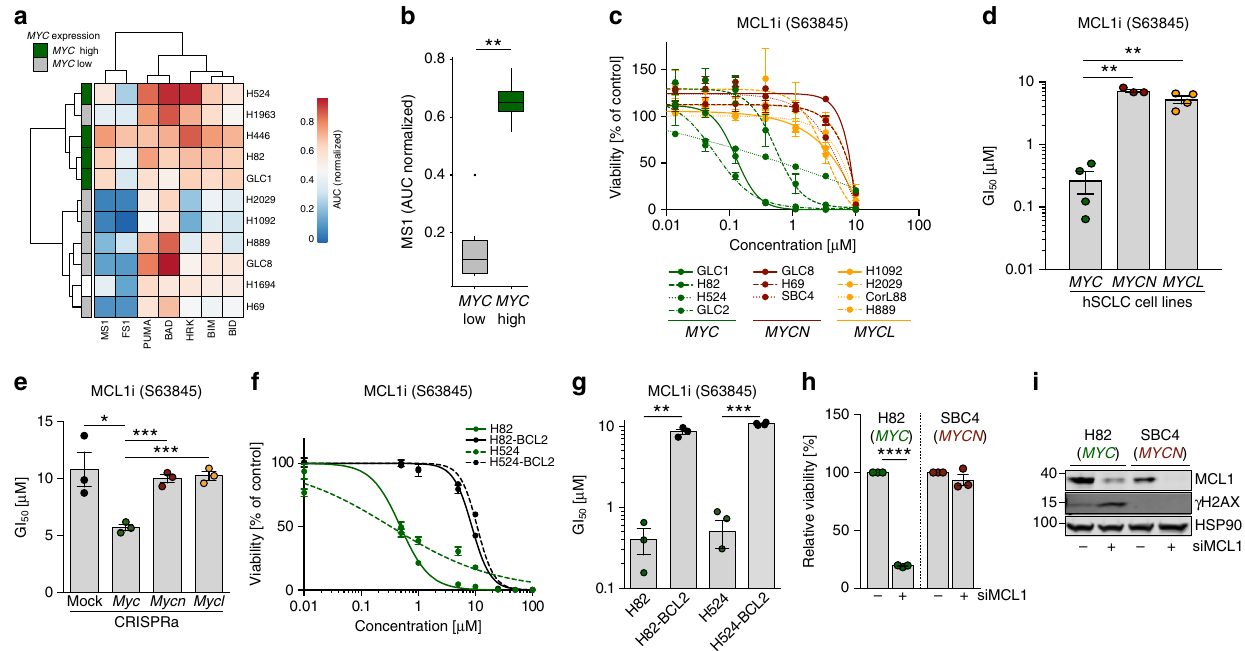
Fig. 3 MYC drives apoptotic priming and MCL1 dependency. a Heatmap of BH3 pro fi ling showing sensitivity of human small cell lung cancer (SCLC) cell lines against speci fi c apoptosis-inducing peptides. MYC expression in the individual cell lines is annotated on the left. b Sensitivity of SCLC cell lines toward apoptosis induction by sensitizer peptide MS1 as marker for MCL1-dependent apoptosis. Cell lines are grouped into MYC low and high expression. Sensitivity is calculated as area under the curve. Center line (median), lower/upper box hinges (25th/75th percentile), whiskers extend to the most extreme value within 1.5× interquartile range (IQR) of the hinges. c Cell viability screening of MYC ( n = 4; GLC1, H82, H524, GLC2), MYCN ( n = 3; GLC8, H69, SBC4), and MYCL ( n = 4; H1092, H2029, CorL88, H889) ampli fi ed human SCLC cell lines treated with MCL1 inhibitor (S63845) for 72 h ( n = 3). d GI 50 values SCLC cell lines treated with S63845. Cell lines are grouped according to their MYC status ( n = 3). e GI 50 values of Myc paralog-activated CRISPRa cells treated with S63845. f Cell viability screening of MYC -ampli fi ed H82 and H524 cells ± BCL2 overexpression treated with S63845 ( n = 3). g GI 50 values of cell viability screening in f ( n = 3). h Relative cell viability of H82 ( MYC -ampli fi ed) and H69 ( MYCN -ampli fi ed) human SCLC cell lines 48 h after transfection with non-targeted small interfering RNA (siRNA) or siRNA directed against MCL1 ( n = 3). i Western blot showing MCL1 and γ H2AX levels in H82 ( MYC -ampli fi ed) and H69 ( MYCN -ampli fi ed) human SCLC cell lines 48 h after Ctrl. or MCL1 siRNA transfection. HSP90 was used as a loading control. Error bars indicate mean ± SEM. Two-tailed unpaired t tests, **** p < 0.0001, *** p < 0.001, ** p < 0.01, * p < 0.05. Source data are provided